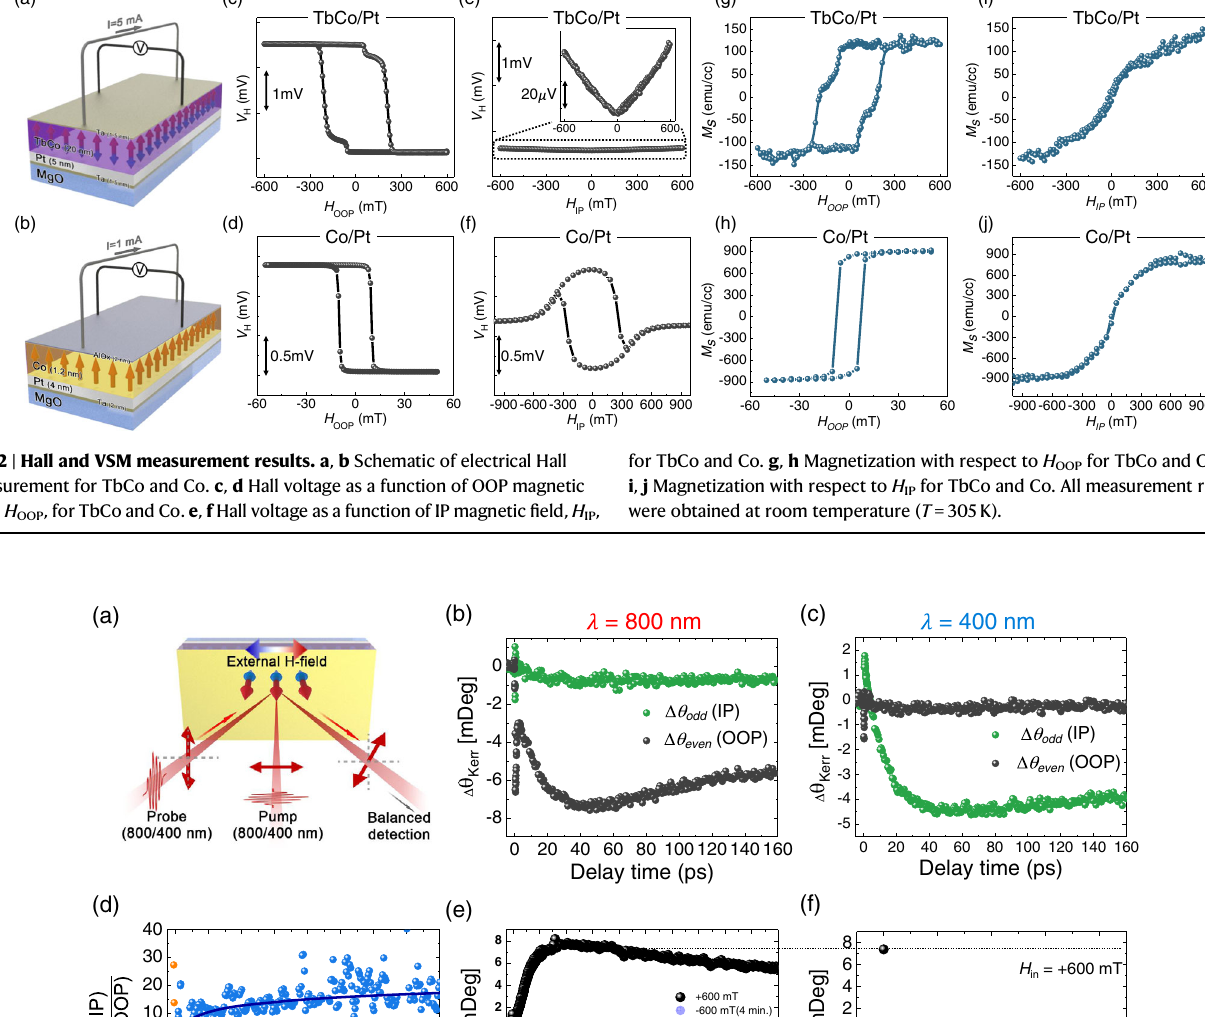
Δ θ even depending on wavelength. e The 400nm pump-probe raw data under external magnetic fi elds (±600 mT) at 305K. f Slow change of Kerr signal at fi xed delay time of 55ps when the external magnetic fi eld is changed from +600mT to − odd and